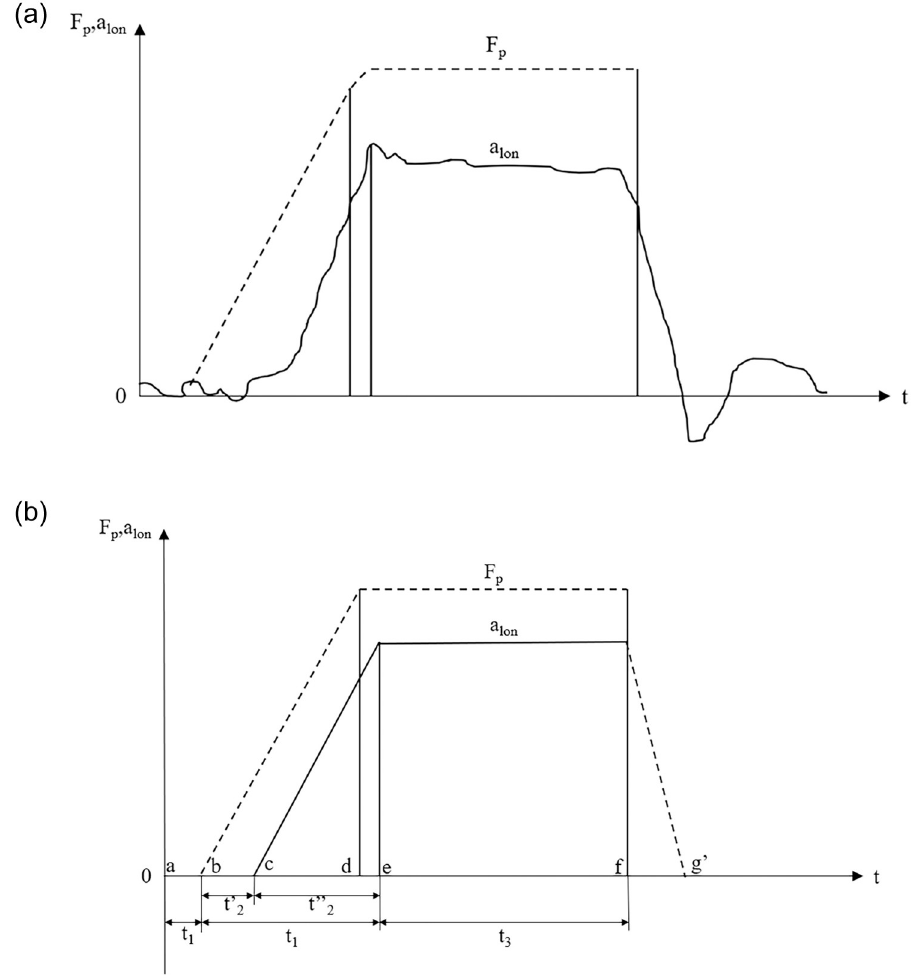
Fig 1. The relationship curve between brake pedal force, vehicle braking deceleration, and braking time: (a) the actual measurement curve, (b) the simplified curve.